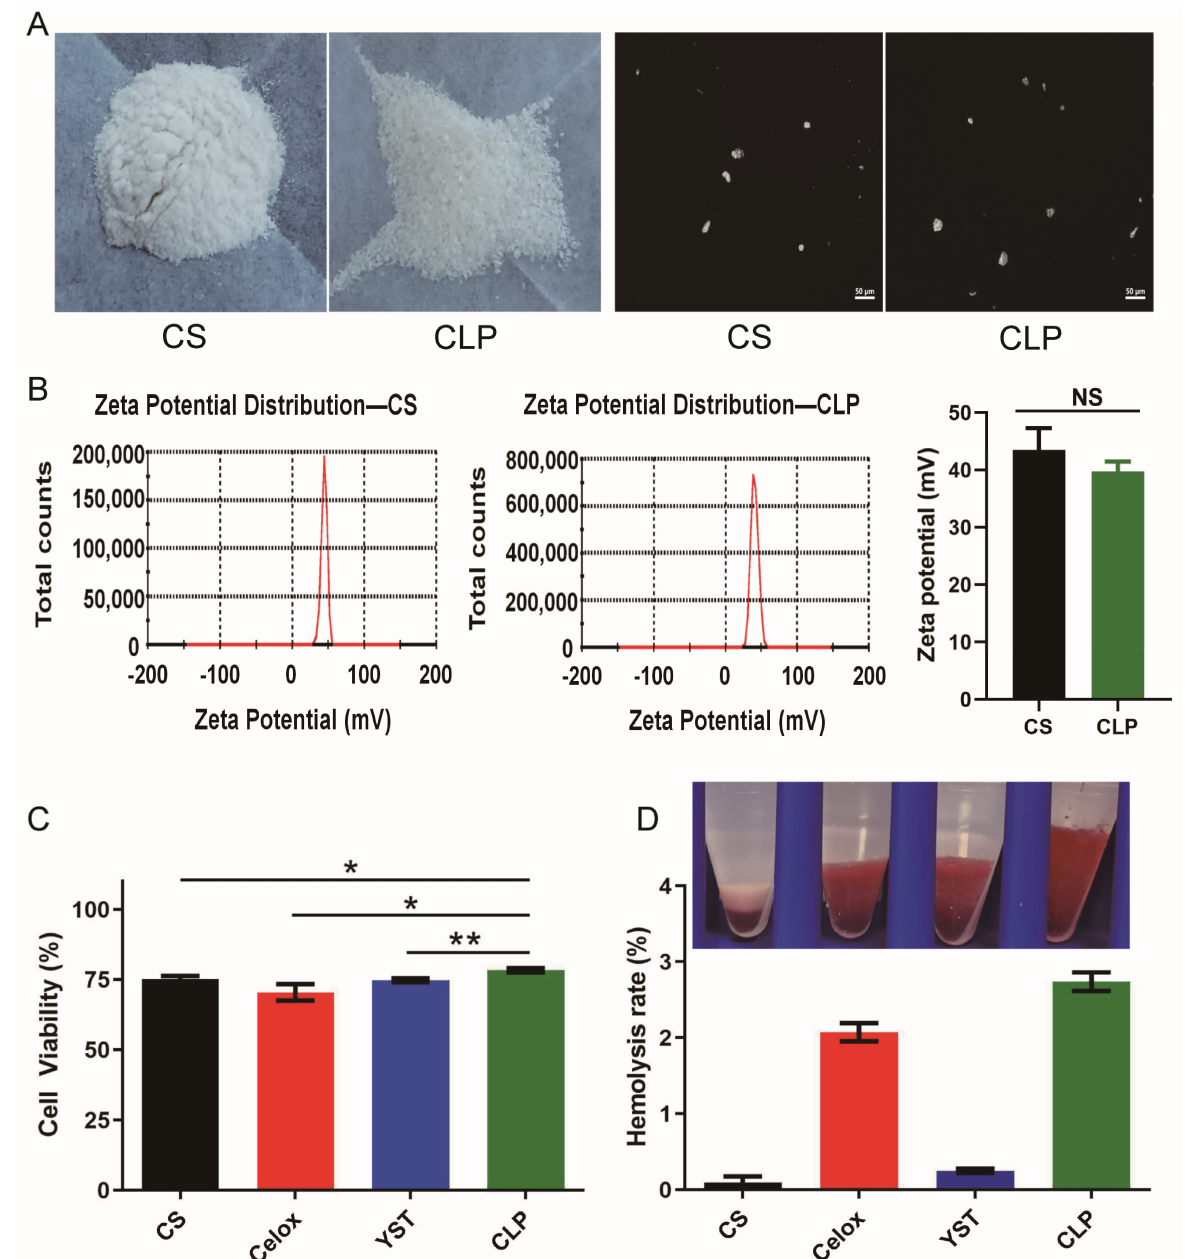
Figure 1. Characterization, cytotoxicity, and blood biocompatibility of hemostatic particles. ( A ) Visual image of hemostatic particles, obtained by camera and ZEISS − AX10 microscope (bar = 50 µ m). ( B ) Zeta potential of hemostatic particles ( n = 3). ( C ) Viability of L929 fibroblasts cultured with extract medium of the materials according to MTT assay ( n = 9). ( D ) Hemolysis rate of hemostatic particles ( n = 9). Values represent means ± SEM. The differences between each group were performed using a two − tailed unpaired t − test. The ‘NS’ indicated no significant difference, * p < 0.05, ** p <